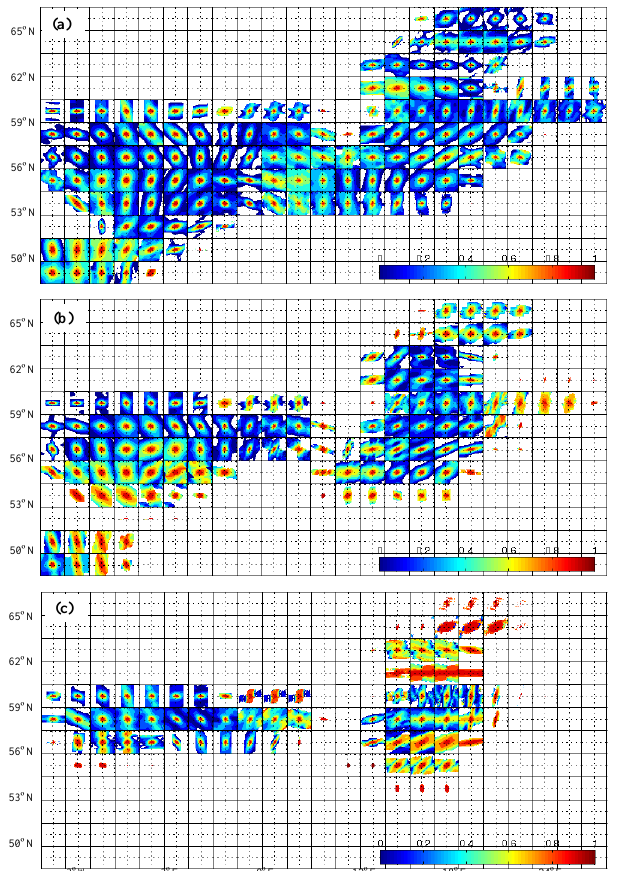
Figure 6, Contours of the spatial averaged correlations in 1.5 º X1.5 º bins calculated from the proxy ocean Fig. 6. Contours of the spatial averaged correlations in 1 . 5 ◦ × 1 . 5 ◦ data at (a) surface, (b) 30 m and (c) 75 m for salinity. bins calculated from the proxy ocean data at (a) surface, (b) 30m and (c) 75m for